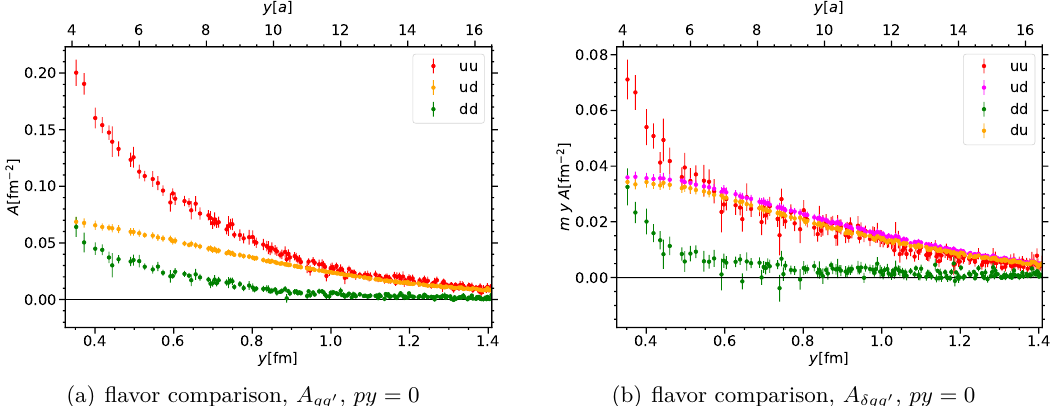
Figure 12 . Twist-two functions A qq 0 (a) and A δqq 0 (b) for py = 0 . In each panel we compare the results for all independent flavor combinations. For A A δqq 0 we additionally have to consider the combination du . Here and in the following plots, only the contributions from the graphs C